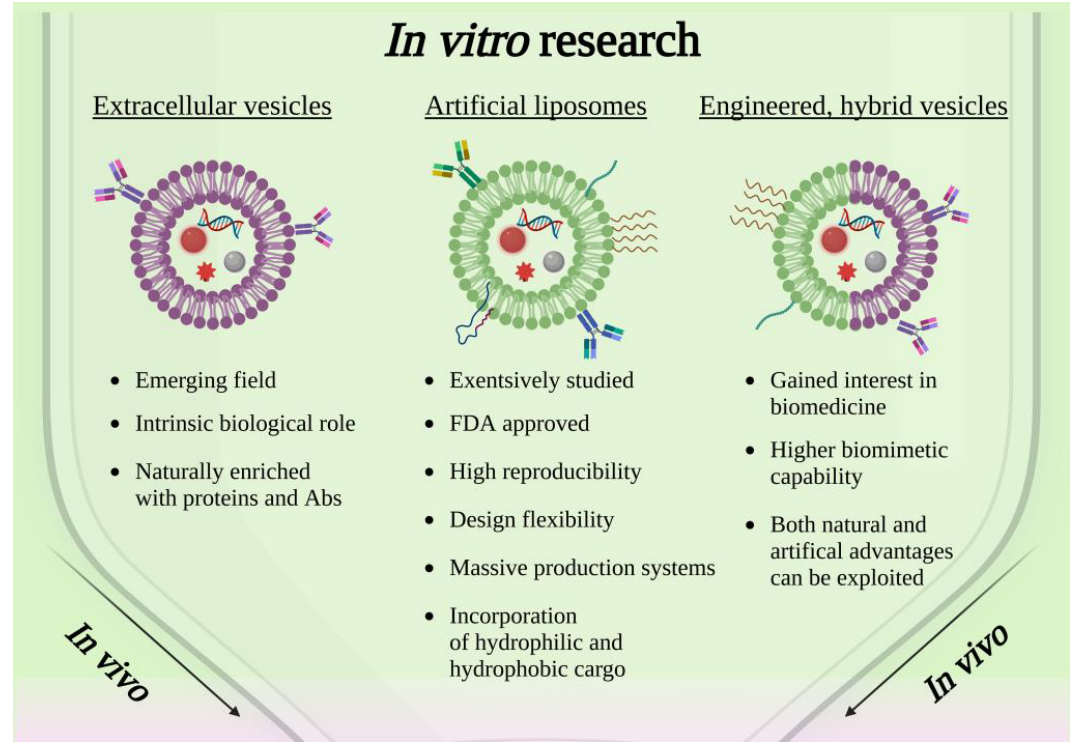
Figure 2. Scheme showing the current panorama of in vitro research involving solid-state nanoparticles enclosed in lipidic-based shell, extracellular vesicles or engineered hybrid vesicles. Created with BioRender.com, accessed on 26 October 2022.